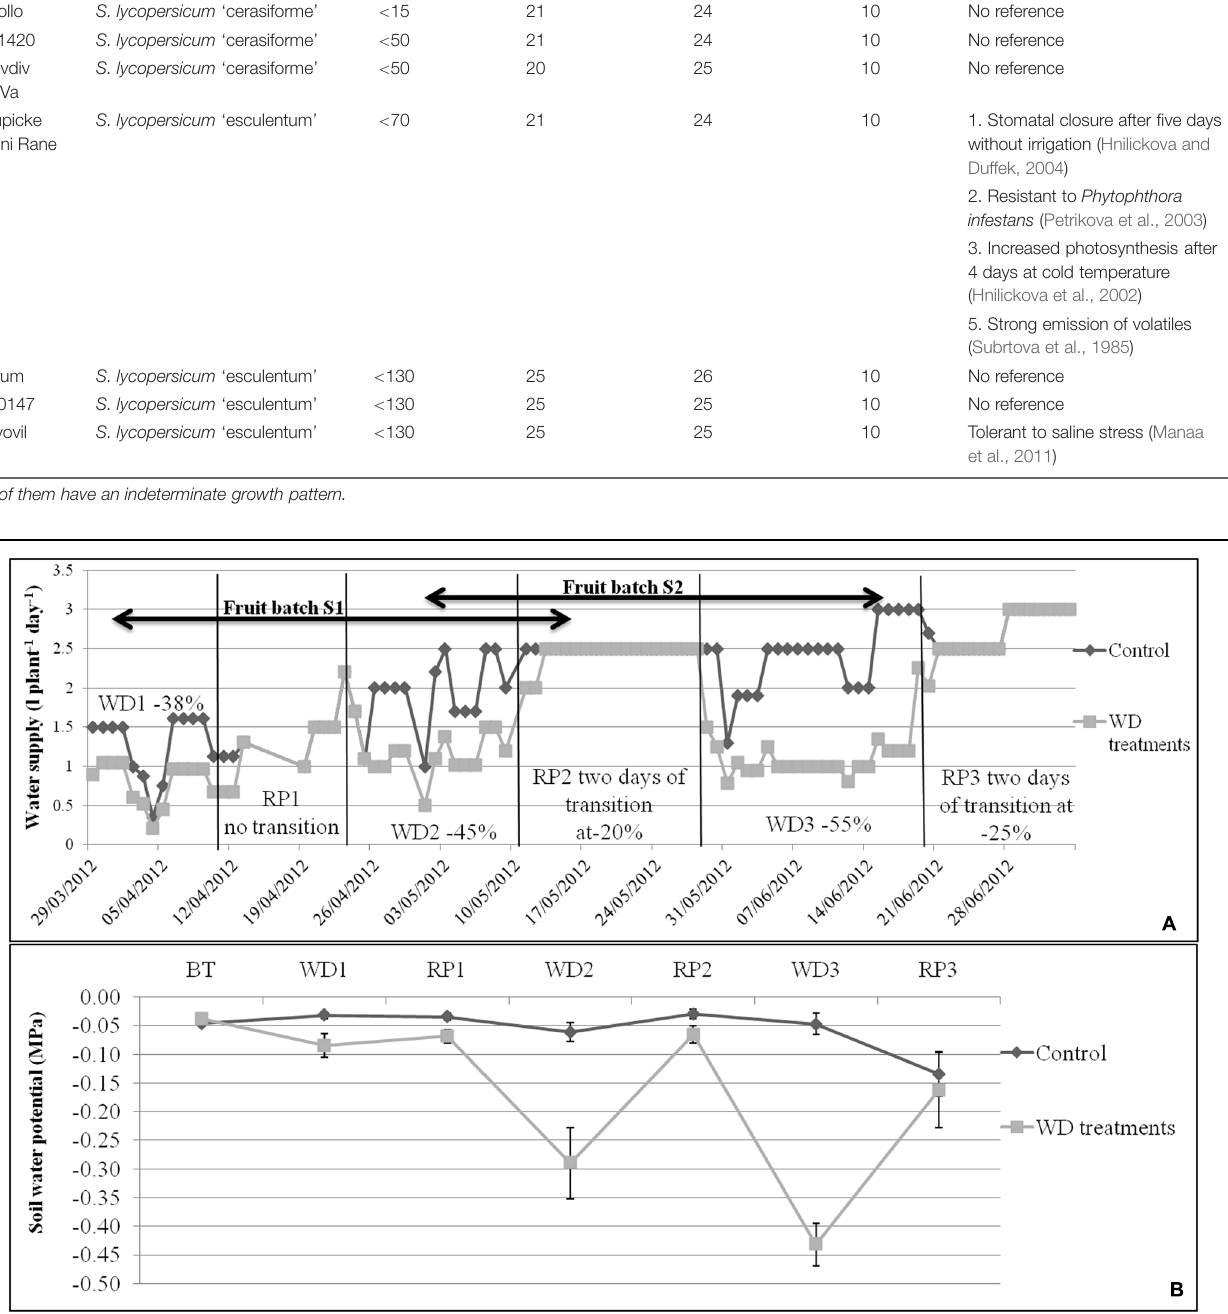
Frontiers in Plant Science |